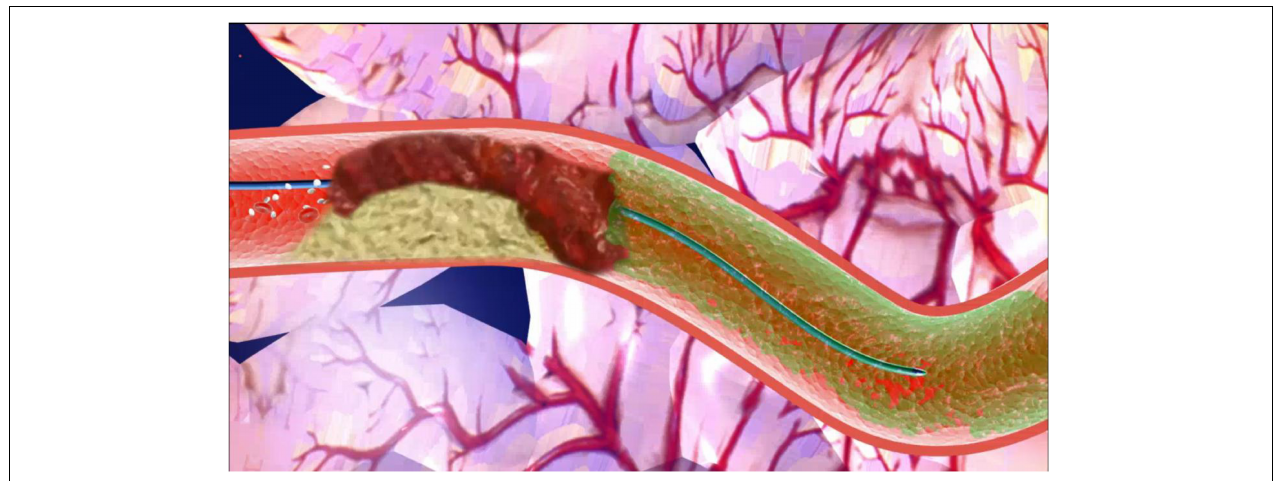
FIGURE 2 | Pattern diagram of intracoronary artery retrograde thrombolysis system. After the passing of the wire, a microcatheter or a cut balloon is sent to the occluded section through the guidewire. One milliliter of thrombolytic cocktail is bolus-injected through the microcatheter to the distal lumen of the vessel, which is repeated every 30